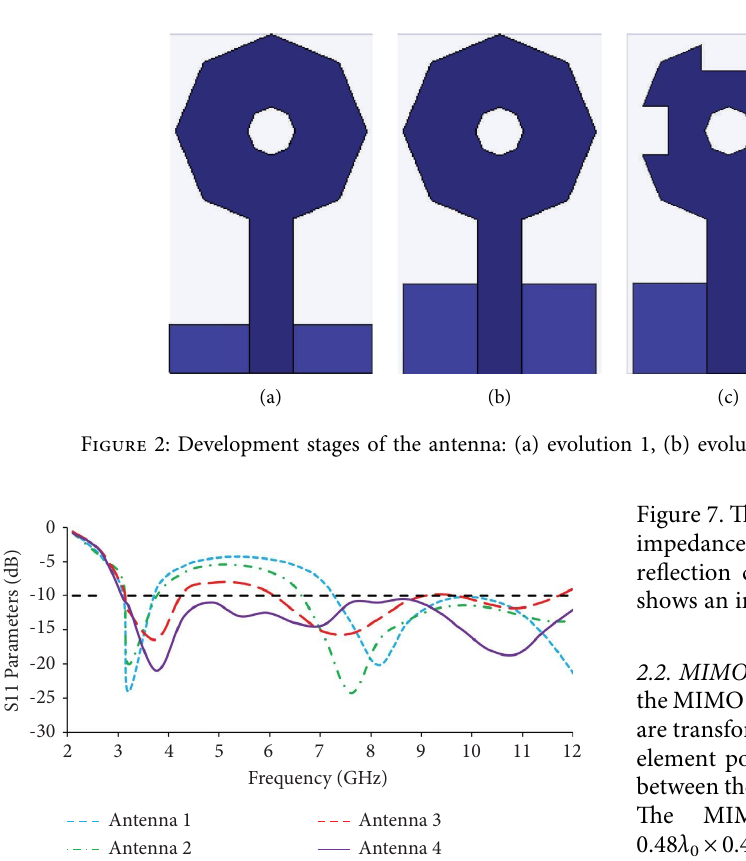
Figure 3: Refection coefcients at various stages of